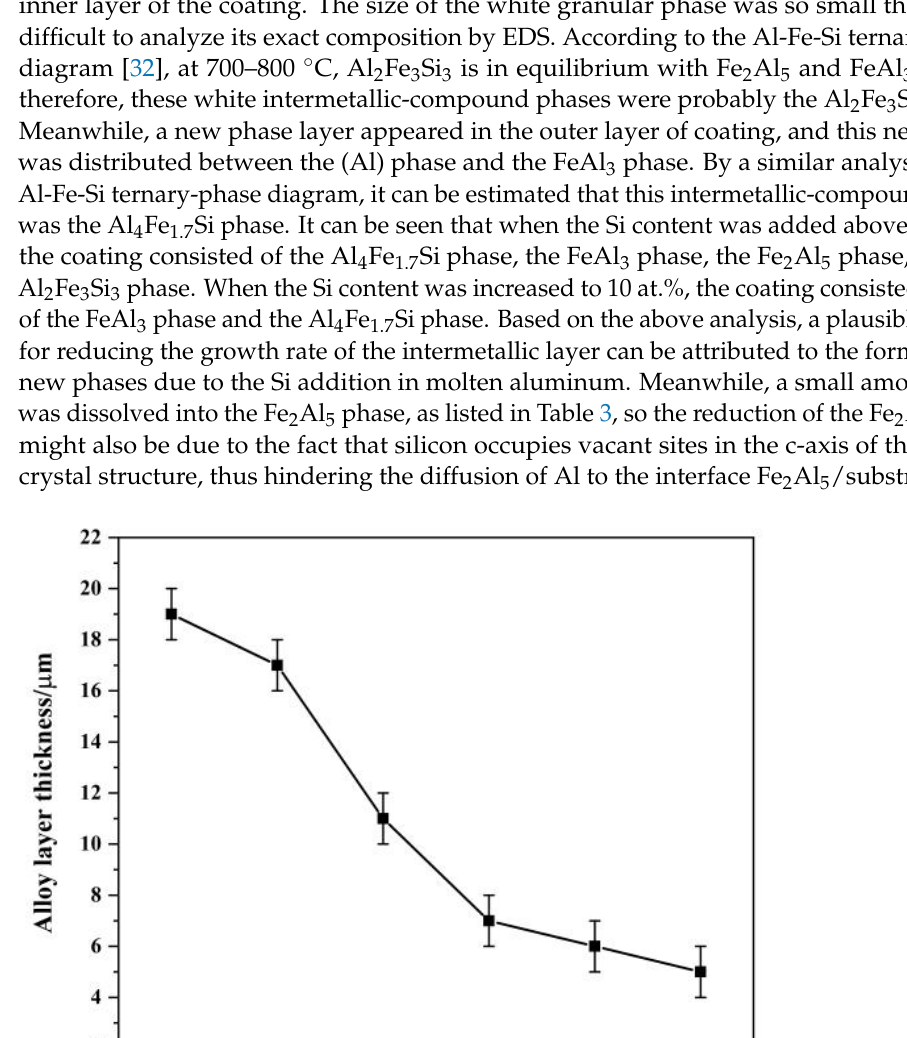
Figure 4. Relationship between intermetallic thickness of Q345 steel after hot-dip aluminum with different silicon content.